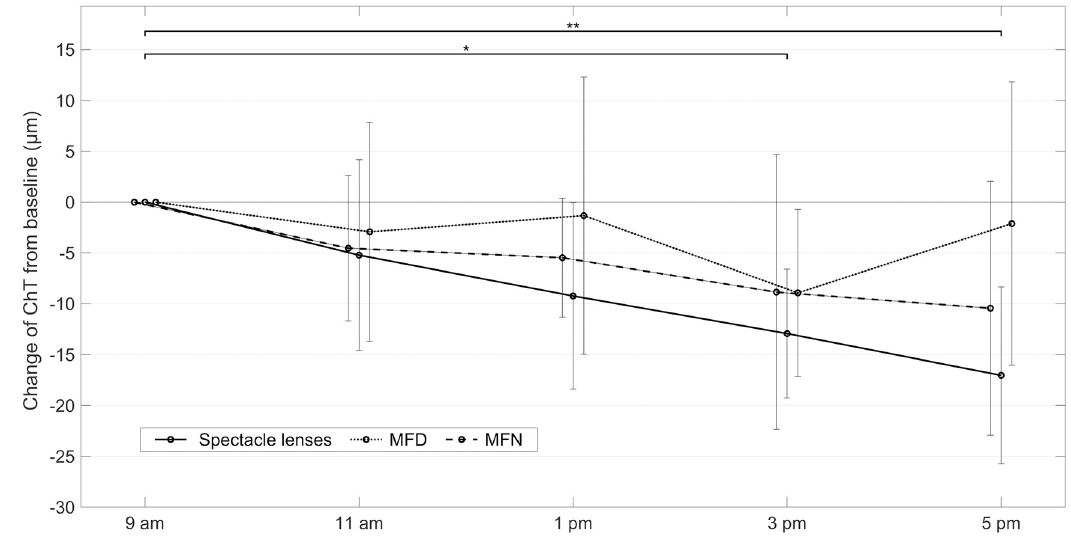
Fig 3. Diurnal choroidal rhythm with different corrections. Central choroidal thickness changes for n = 3 subjects from 9 am to 5 pm. The ChT in the afternoon was significantly thinner compared to the morning values only with the spectacle correction only (9 am to 3 pm: p = 0.03; 9 am to 5 pm: p = 0.008). There was less thinning with both multifocal contact lenses. The horizontal offset of the values at each time point is only for reasons of clarity. Errorbars indicate the standard